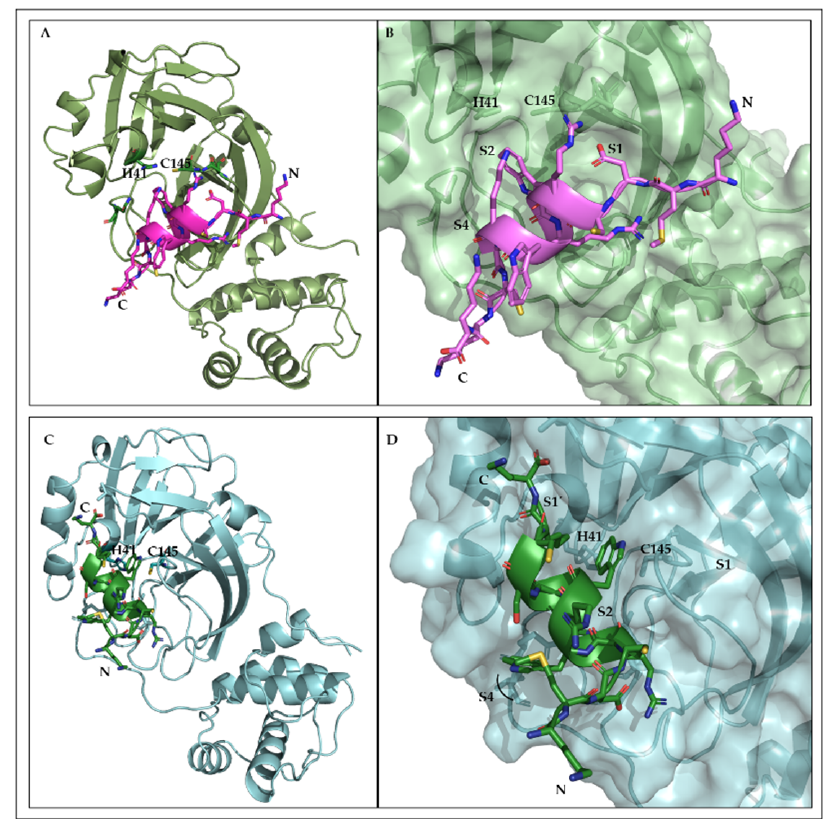
Figure 7. SARS-CoV-2 3CL pro binding site. ( A ): Cartoon representation of the protease in complex with the L-CDP1 peptide (cartoon/sticks); the side chain of the catalytic residues His41 and Cys145 are shown in sticks representation. ( B ): Surface representation of the 3CL pro complex with the L-CDP1 peptide (cartoon/sticks). The interaction interface of the peptide with the substrate-binding sites, which is blocked by the peptide, is shown according to S1, S2, and S4. ( C ): Cartoon representation of the protease in complex with the L-CDP7 peptide (cartoon/sticks); the side chain of the catalytic residues His41 and Cys145 are shown in sticks representation. ( D ): Surface representation of the 3CL pro complex with the L-CDP7 peptide (cartoon/sticks). The interaction interface of the peptide with the substrate-binding sites that are blocked by the peptide is shown according to S1’, S2, and S4. MD simulation revealed a possible mode of interaction of the L-CDP1 peptide with SARS-CoV-2 3CL pro . Therefore, the amino acid residue of the active site does not interact directly with the peptide; however, the L-CDP1 is accommodated in the